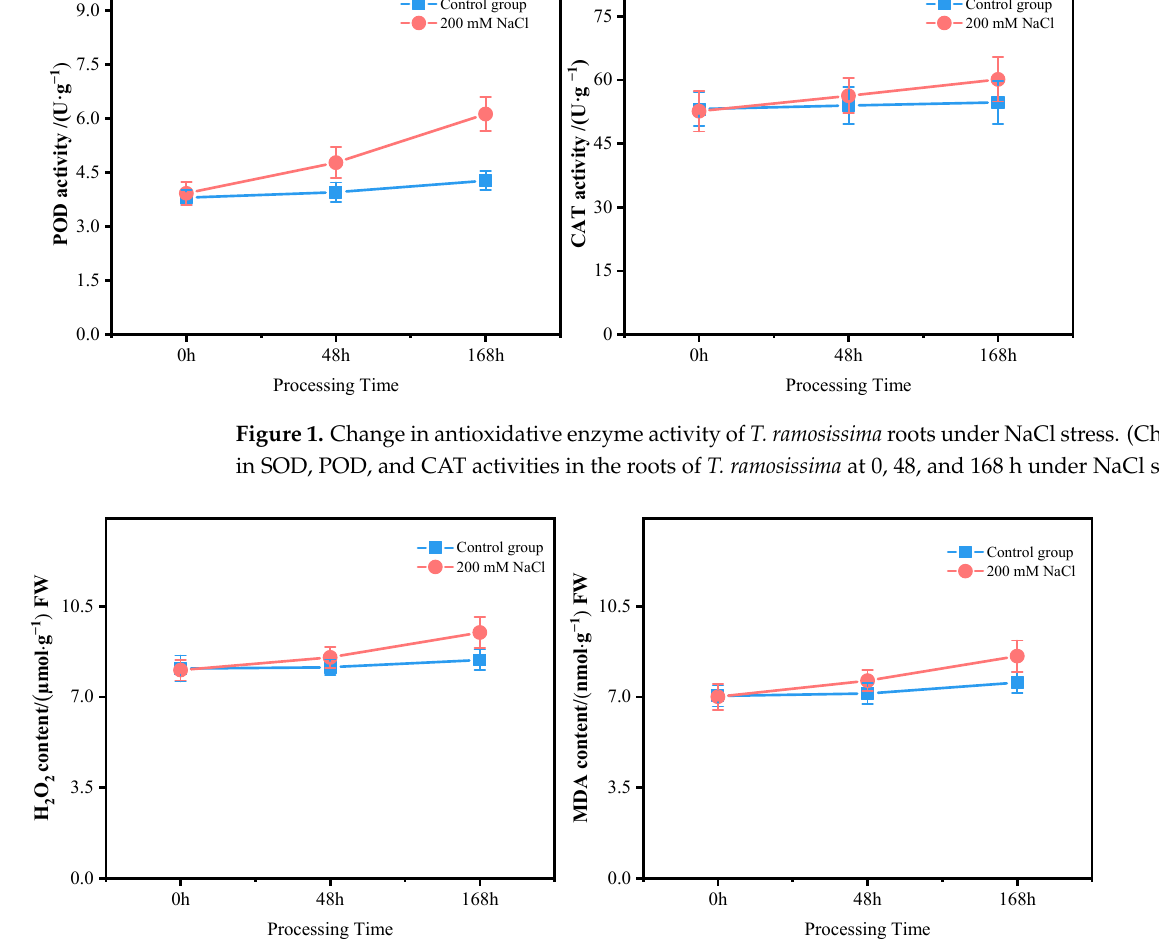
Figure 2. Change in H 2 O 2 and MDA content of T. ramosissima roots under NaCl stress. (Changes in H 2 O 2 and MDA content in roots of T . ramosissima under different treatments at 0, 48, and 168